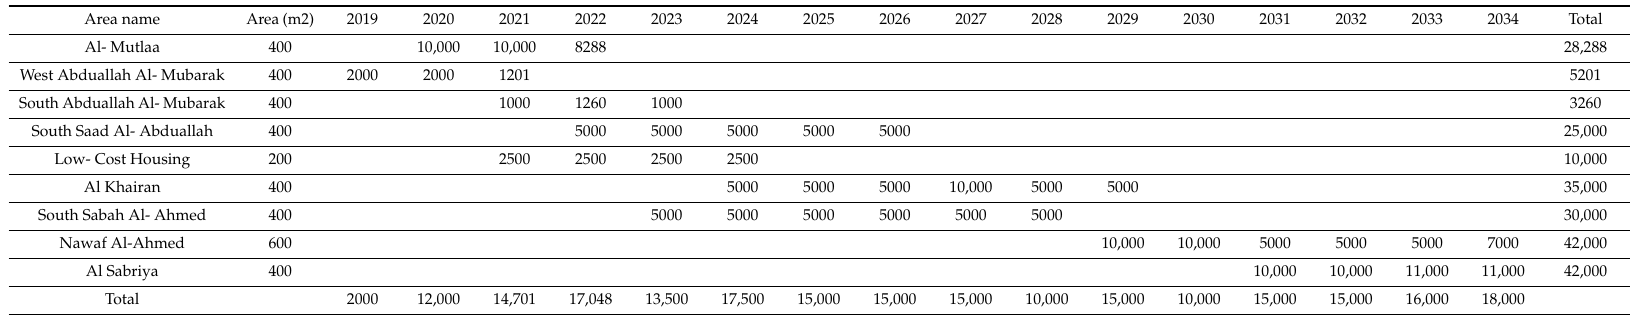
Table 4. Total housing subsidies provided by the Public Authority of Housing Welfare (PAHW) for various cities in Kuwait up to the year 2034 [49].